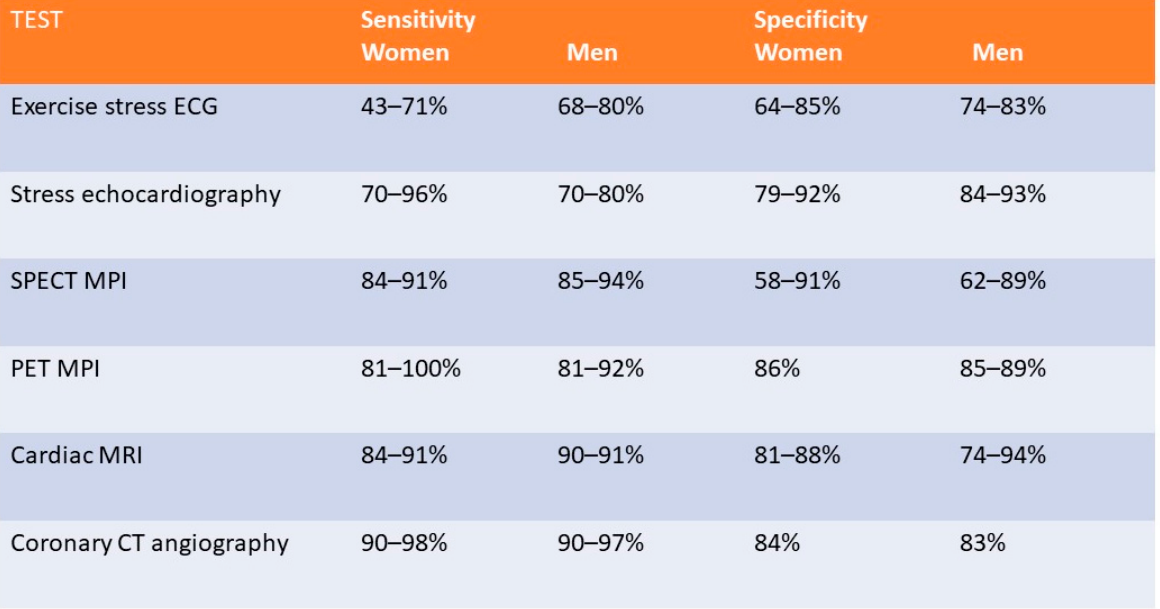
Figure 1. Figure comparing the sensitivity and specificity of different non-invasive imaging modalities in men and